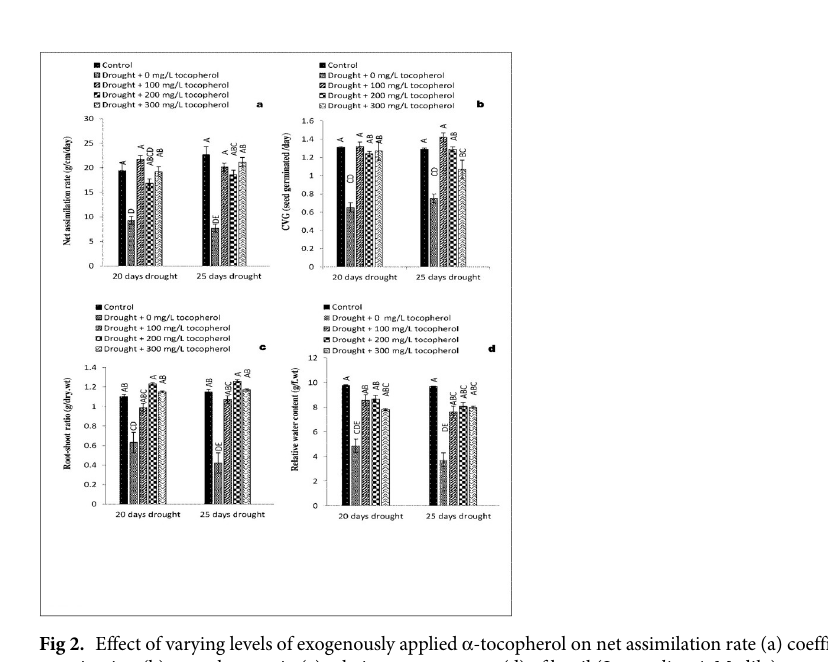
at ( P � 0.05) in control group only (Fig 3A and 3B). Same growth parameters were studied under 25-days of drought induced stress sprayed with the same levels of α -tocopherol. Results showed significant improvement at ( P � 0.05) in AGR, LAI, and LAR with the application of